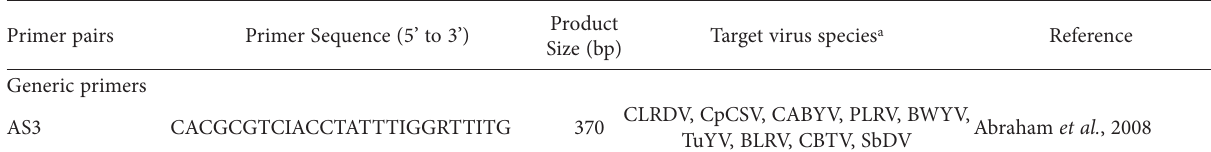
Table 1. Luteovirid primer sets used in this study. Primer